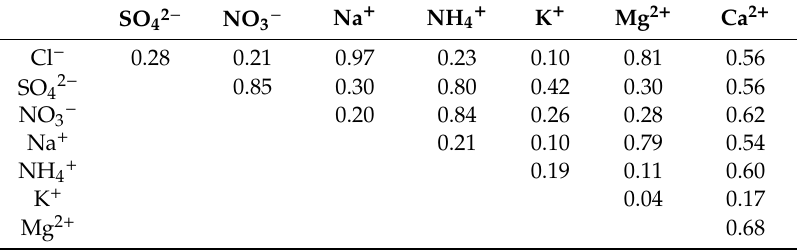
Figure 6. Variation of anion and cation concentrations in monthly precipitation collected at Toki, Japan. Table 1. Correlation coefficients of ion species in monthly precipitation collected at Toki, Japan.